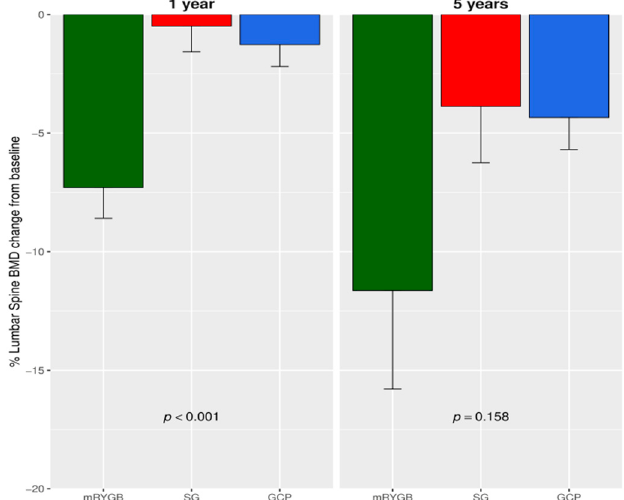
Figure 2. Percentage lumbar spine BMD change at year 1 and 5 from baseline. mRYGB, metabolic gastric bypass; SG, sleeve gastrectomy; GCP, greater curvature plication. p -value result from comparing mRYGB with SG and GCP.